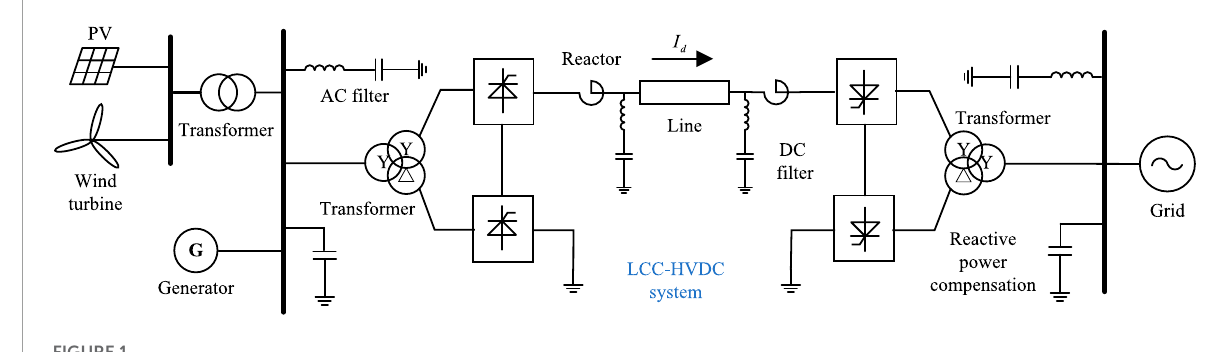
FIGURE 1 Structure of LCC-HVDC sending end power system with renewable energy.